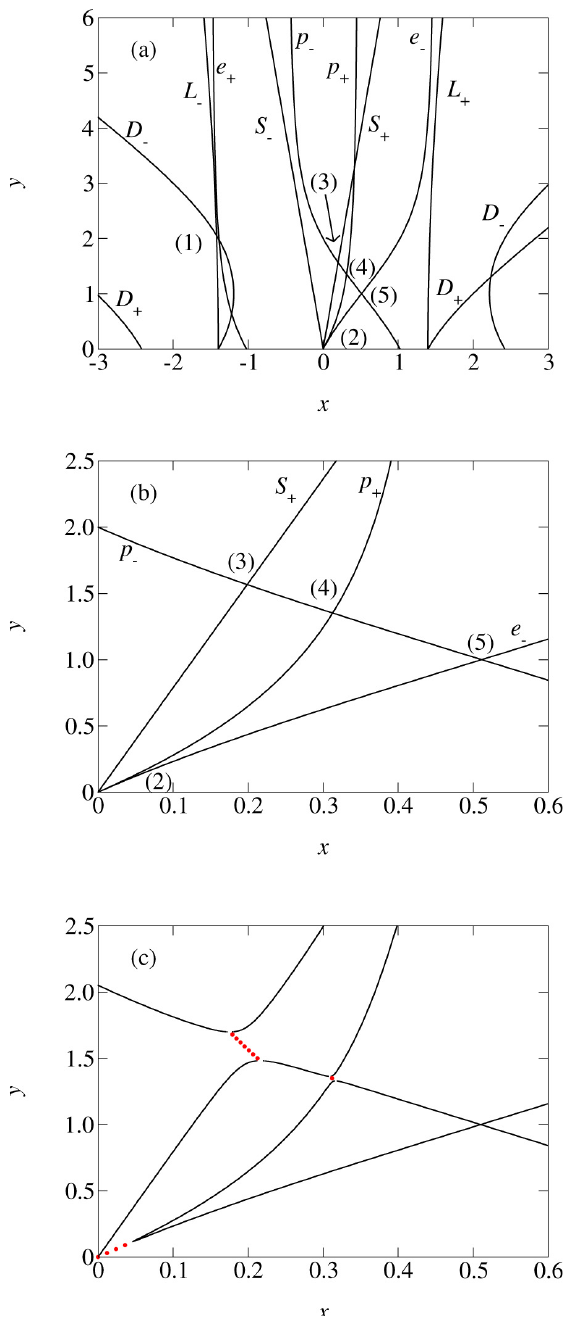
Fig. 12. (Color online) Solution of the dispersion relation Eq. (57). Normalized wave number y = kc/(cid:127) c vs. normalized frequency x = ω/(cid:127) c for y 0 = 1, ω p /(cid:127) c = 1, 1 /µ = 0 . 01. We take the pump wave at the Alfvén branch. (a) α = 0. (b) Sector of interest for α = 0, (c) α = 0 . 1. Dotted lines represent the real part of the so- lution when it is